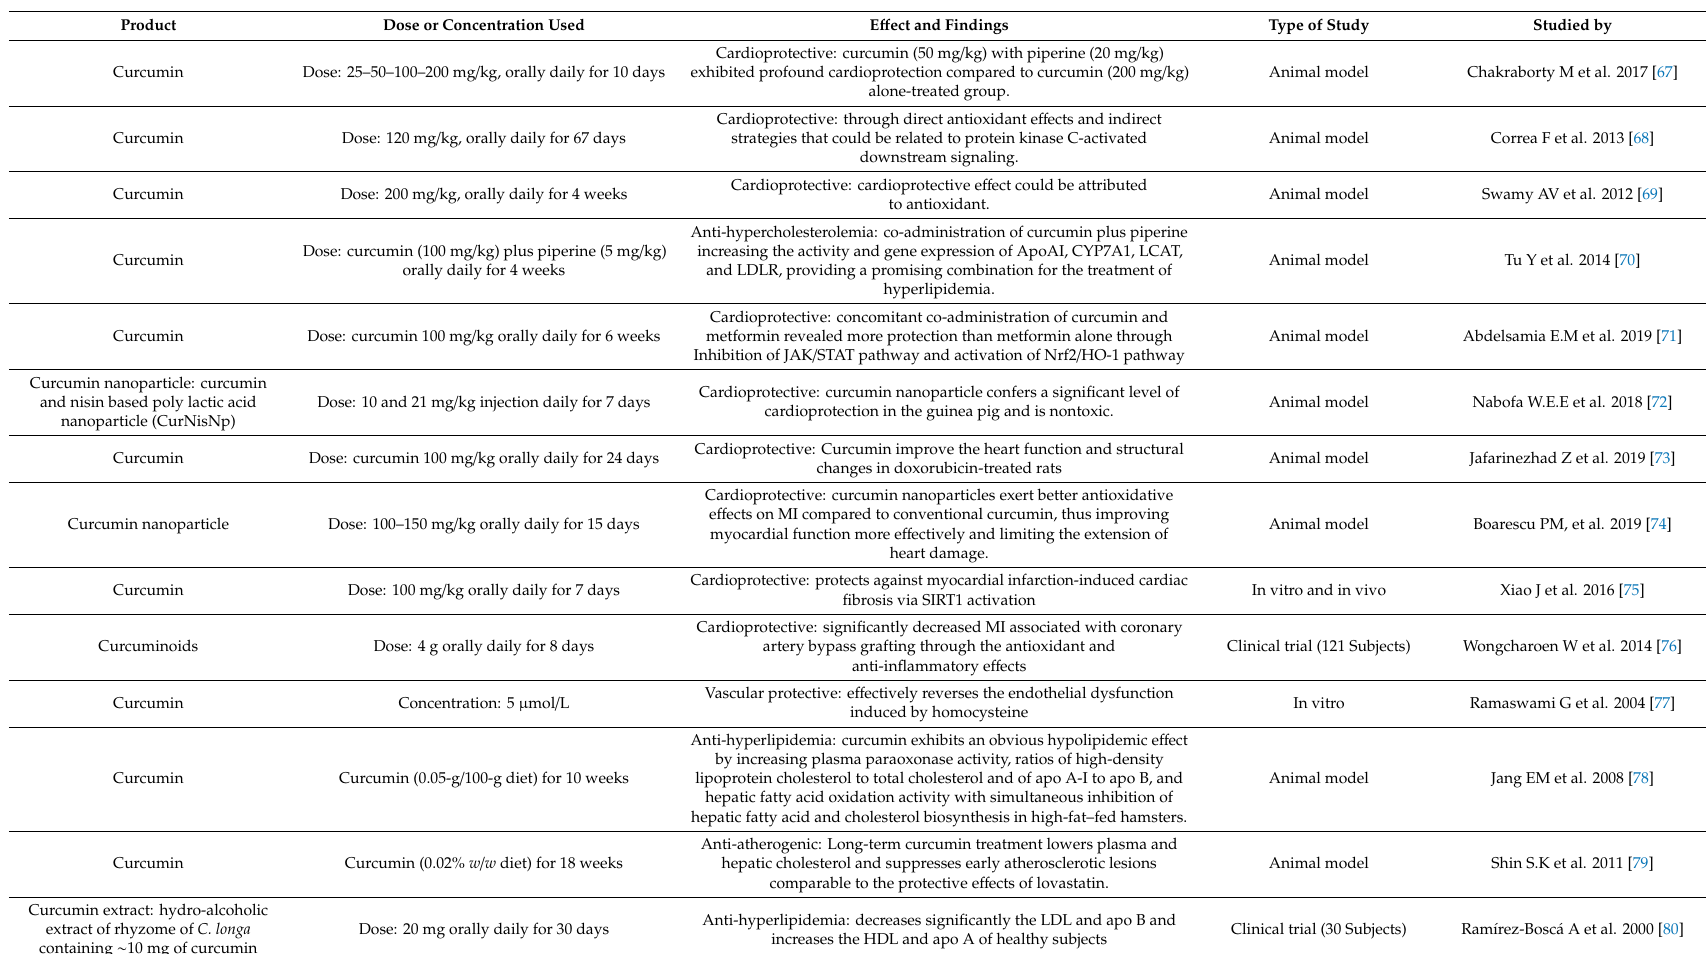
Table 3. Cardiovascular Protective E ff ect of